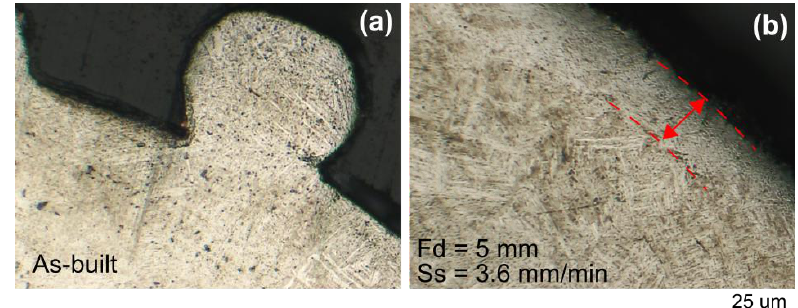
Figure 14. Microhardness along the cross section.